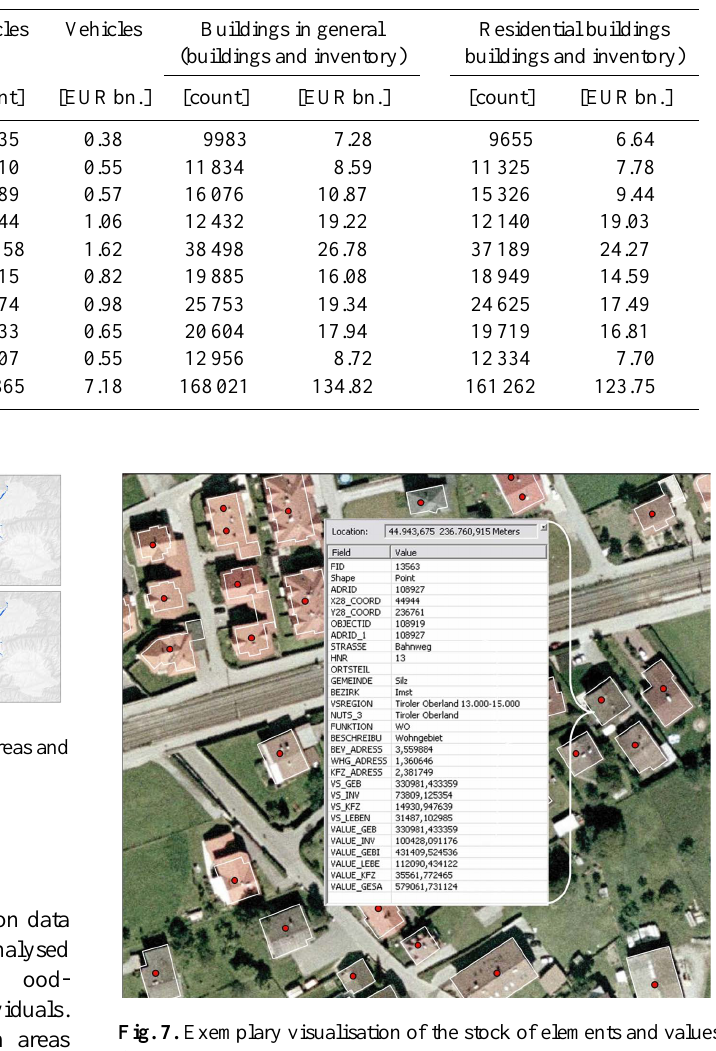
Table 2. The analysed and considered stock of elements and values aggregated on a district level for the risk categories of individuals, vehicles, and buildings (including inventory). The buildings results are classified for all addresses in general and for the addresses of residential buildings in Tyrol.